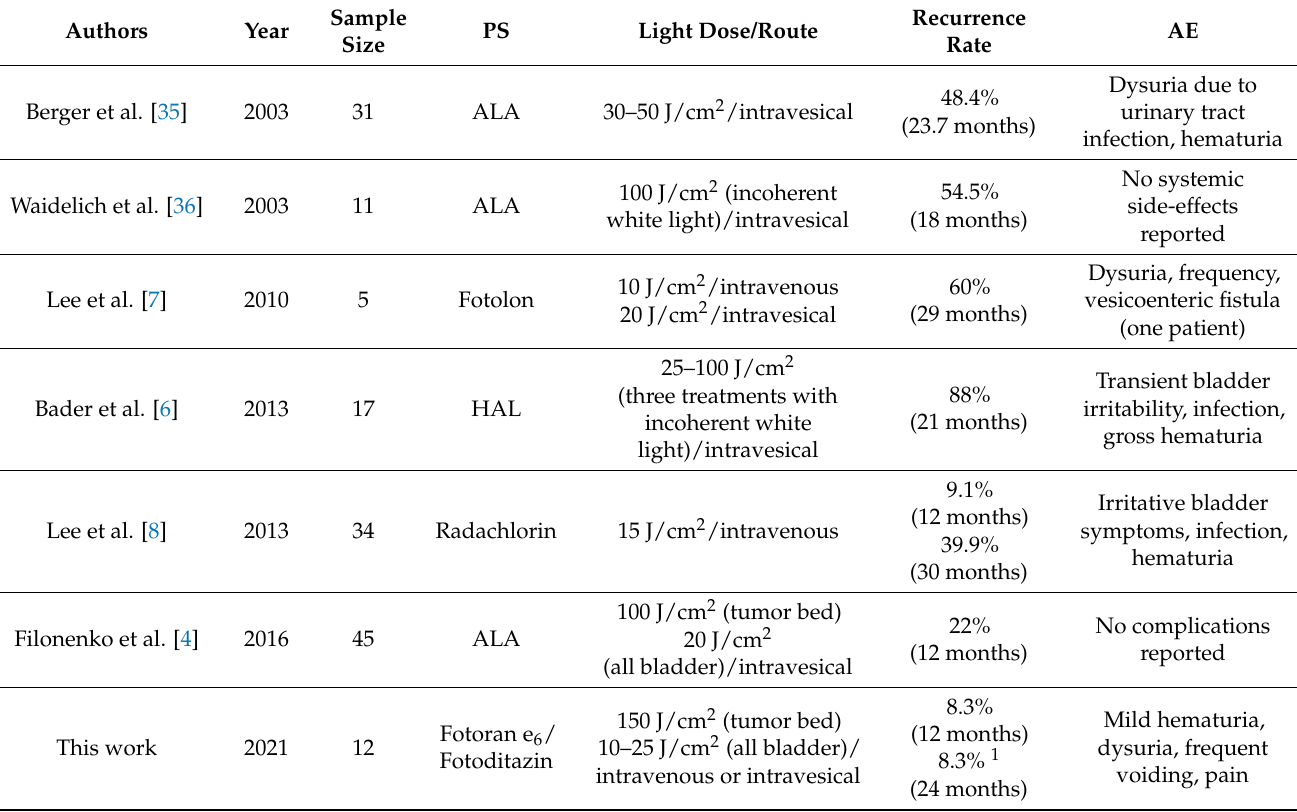
Table 3. Clinical studies for NMIBC treatment with second-generation